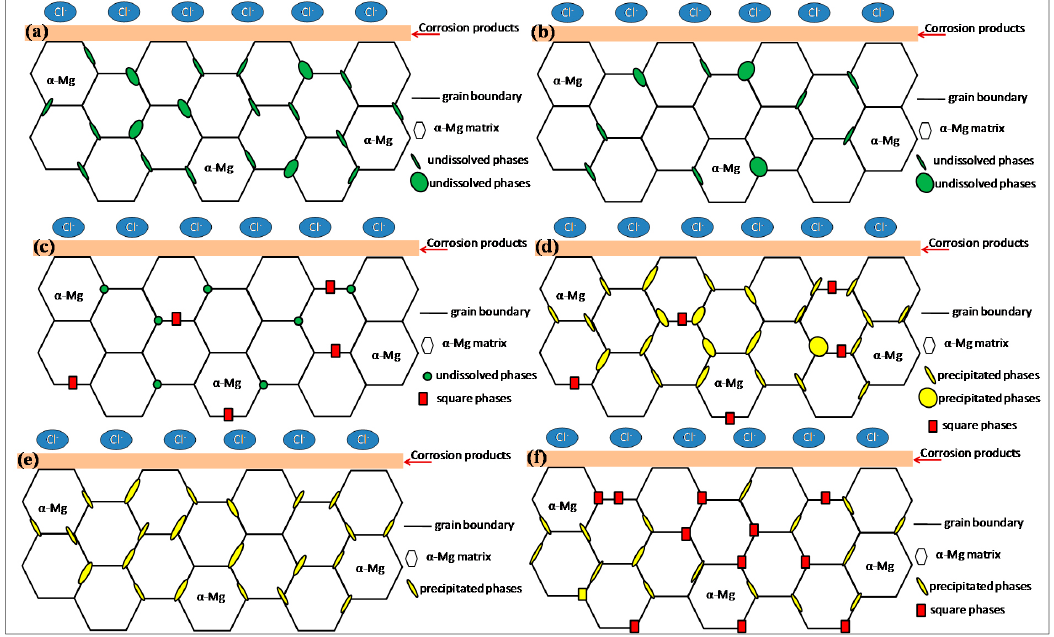
Figure 14. Schematic diagrams of microstructure in relation to the corrosion mechanism of different samples: ( a ) T4-air quenching; ( b ) T4-water quenching; ( c ) T4-cryogenic quenching; ( d ) T6-air quenching; ( e ) T6-water quenching; and ( f ) T6-cryogenic quenching.